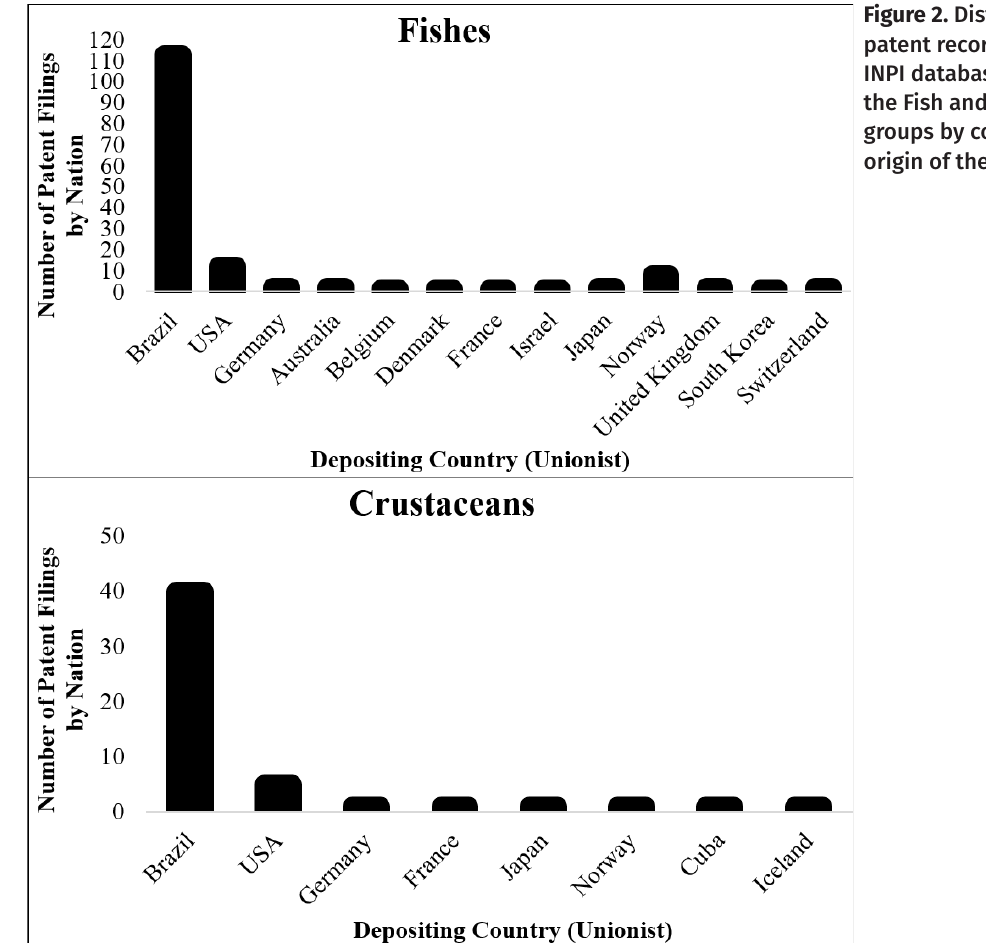
Figure 2. Distribution of patent records from the INPI database related to the Fish and Crustacean groups by country of origin of the